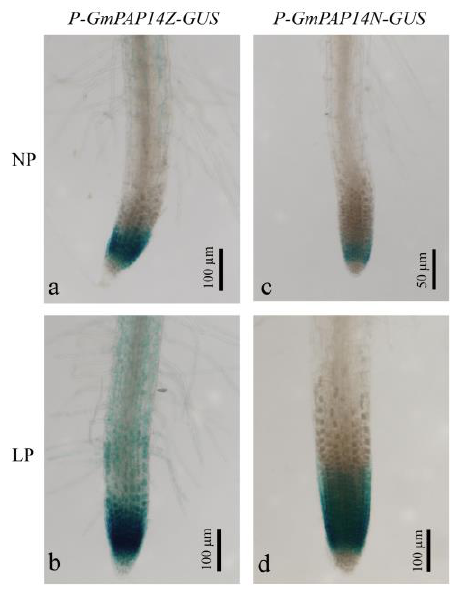
Figure 2. Variational analysis of the GmPAP14 promoter in roots of transgenic Arabidopsis . The T 3 transgenic plants with P-GmPAP14Z-GUS and P-GmPAP14N-GUS were grown on agar under normal P (NP, 1 mmol/L KH 2 PO 4 ) and low P (LP, 1 mmol/L phytate) conditions. Then, the roots were harvested for GUS staining after 21 d.